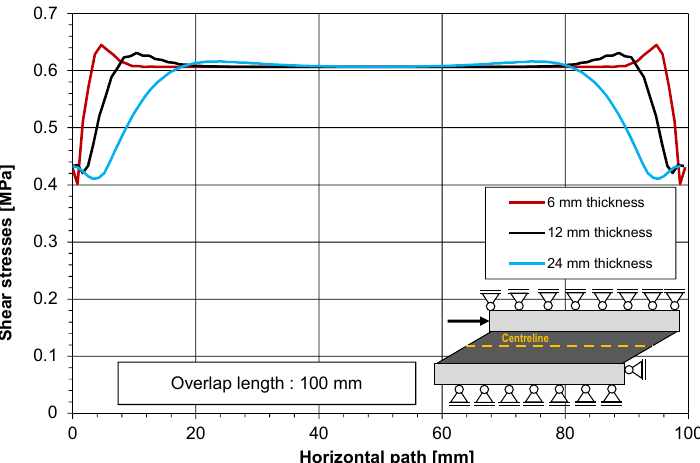
Fig. 25 Shear stress distribution at the centreline of the silicone sealant for different thicknesses and the same element size as well as the same applied engineering shear strain. A constant overlap length of 100 mm is considered.